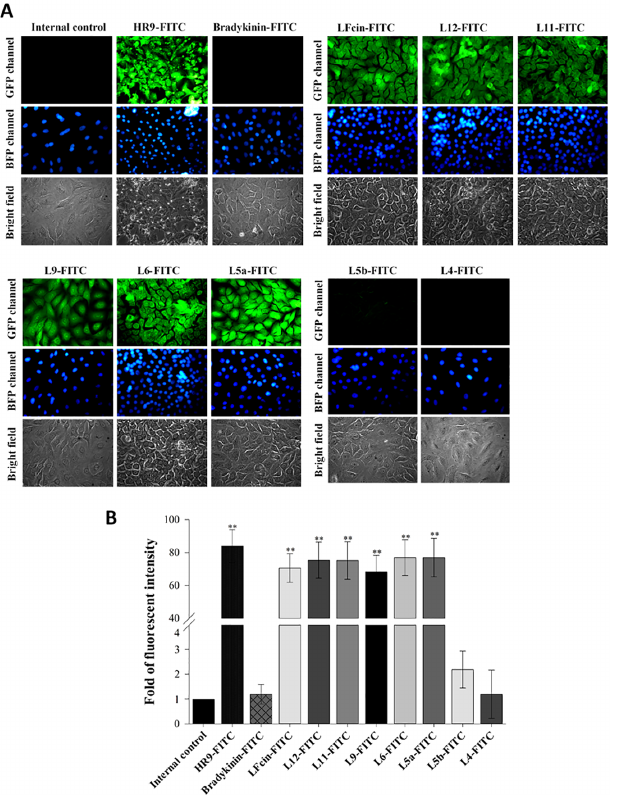
Fig 2. Fluorescent microscopy of cellular uptake of eight FITC-labeled LFcin derivatives into A549 cells. (A) Fluorescent images of cells treated with FITC-labeled LFcins. Cells were treated with 10 μ M FITC- labeled LFcins for 1 h, and then stained with Hoechst 33342. Cells not exposed to LFcins served as internal controls. Cells were treated with HR9-FITC and bradykinin-FITC as positive and negative controls, respectively. GFP, BFP channels and bright fields revealed the distributions of FITC-labeled LFcins, nuclei and cell morphologies. All images are obtained using a Motic AE31 fluorescent microscope with a magnification of 400×. (B) Quantification of the uptake of FITC-labeled LFcins. The fluorescent intensity of cellular internalization was quantified using UN-SCAN-IT software. Each experiment group was compared with the internal control and statistical differences were calculated using the Student's t -test. Significant differences from HR9-FITC at P < 0.01 ( ** ) are indicated. Data are presented as mean ± SD from five independent experiments in each treatment